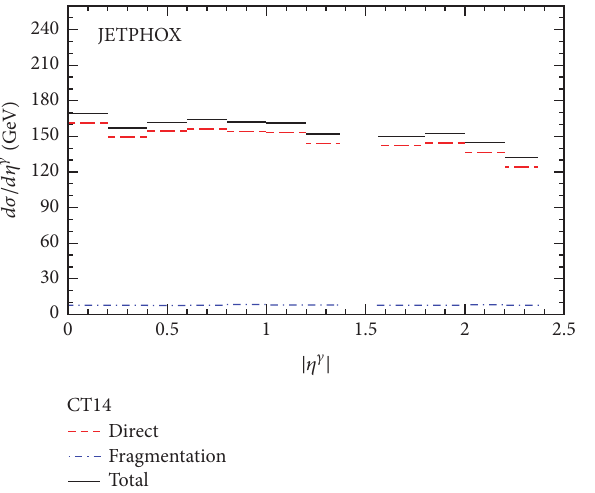
Figure 2: Same as Figure 1, but as a function of 𝜂 𝛾 .